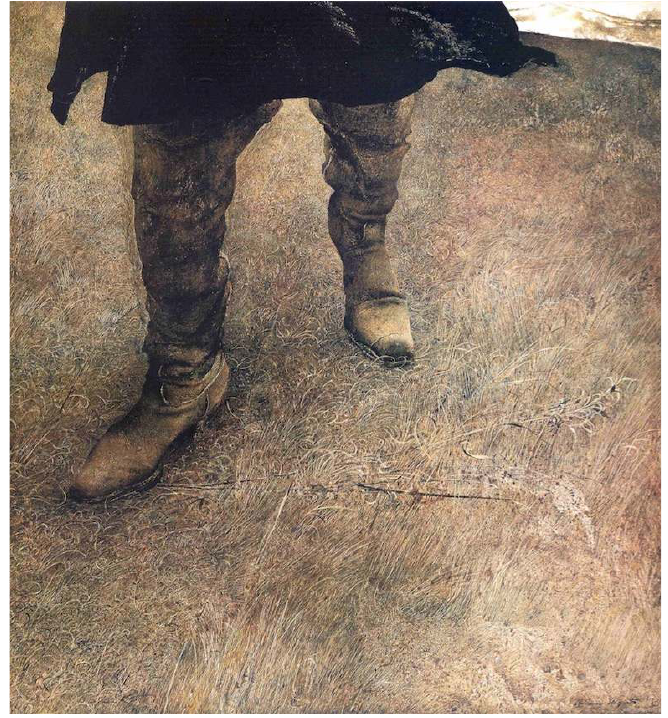
Figure 17. Andrew Wyeth, Trodden Weed . Tempera